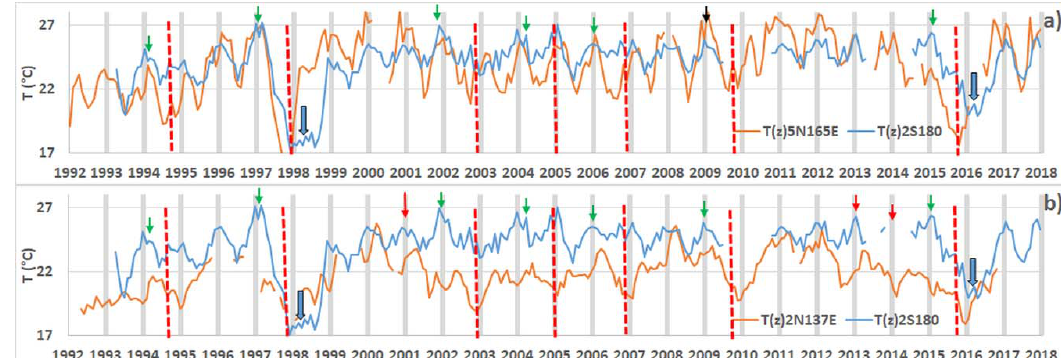
Figure 10. ( a ) The top plot represents the monthly subsurface water temperature at 5° N 165° E averaged over 100 to 150 m in depth and at 2° S 180° W averaged over 125 to 175 m in depth. ( b ) The bottom plot represents the subsurface water temperature at 2° N 137° E averaged over 100 to 200 m in depth and at 2° S 180° W averaged over 125 to 175 m in depth. Dashed red lines indicate the maturation phase of ENSO events. Green arrows depict harbingers of ENSO events; red arrows depict false harbingers detected and the black arrow denotes a true harbinger that was rejected. Thick arrows show the temperature drop during the intensification of La Niña. Peaks occurring during the maturation phase of ENSO events are ignored since they necessarily concern the annual QSW (two successive ENSO events are separated by at least 1.5 years). It should be noted that seasonal forecasting centers predicted an El Niño for 2012, while it should have occurred in early 2013. Geostrophic forces occurring in the tropical basin can be materialized by considering the subsurface water temperature at particular locations of the western off ‐ equatorial antinodes nearly in the opposite phase with respect to the central ‐ eastern antinode. Indeed, as displayed in Figure 4, the subsurface water temperature at 2° N 137° E averaged over 100 to 200 m in depth, which is located